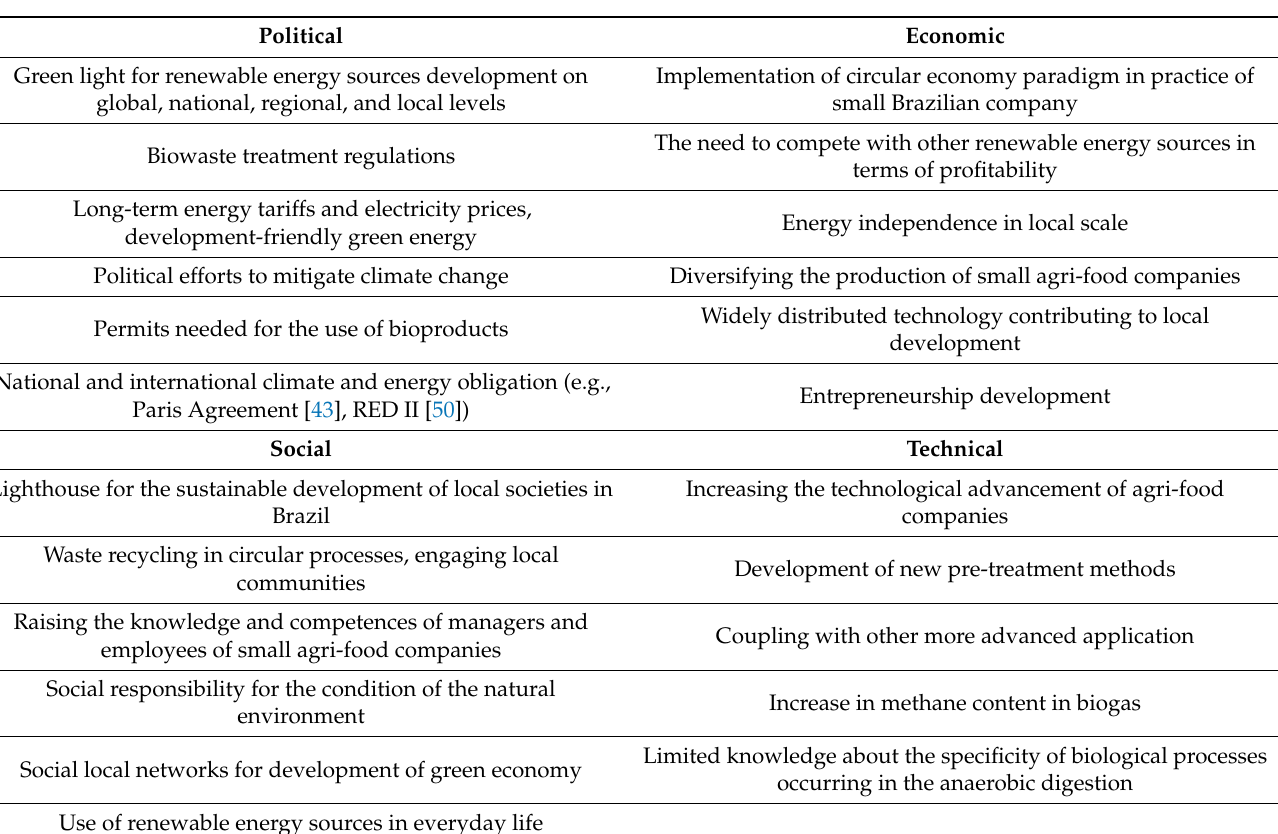
Table 7. The PEST analysis of biogas implementation, prepared on the basis of this work and results presented